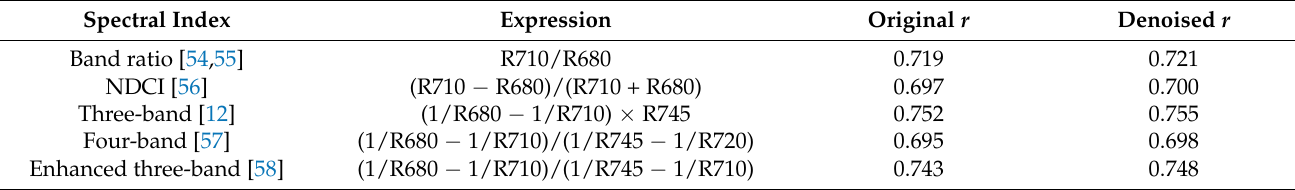
Table 2. Linear correlation coefficients between C chla and five spectral indices that calculated from original R rs and denoised R rs